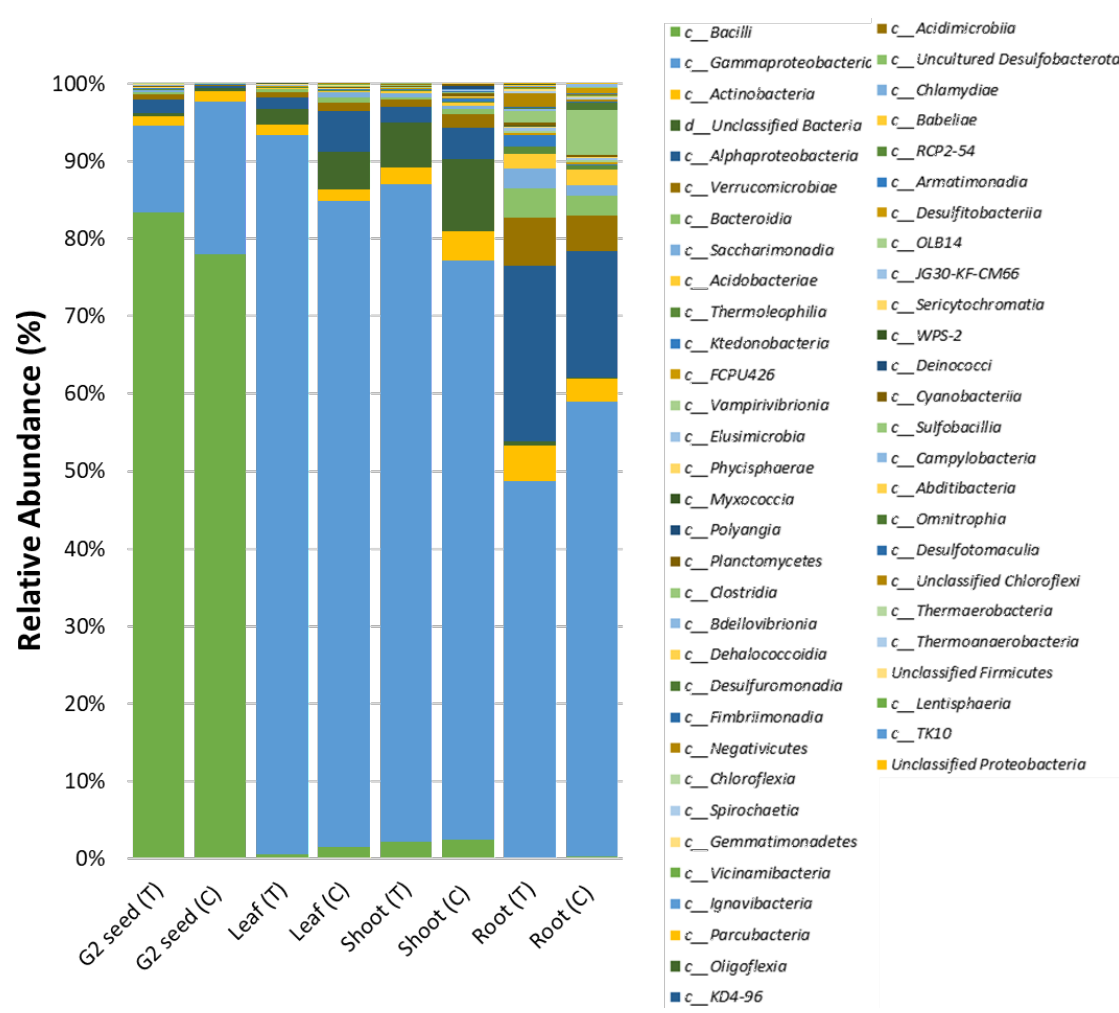
Figure 6. Relative abundance of G. clandestina microbiomes across different plant organs (root, shoot, leaf and G2 seed) of mature plants (G1) at class level.